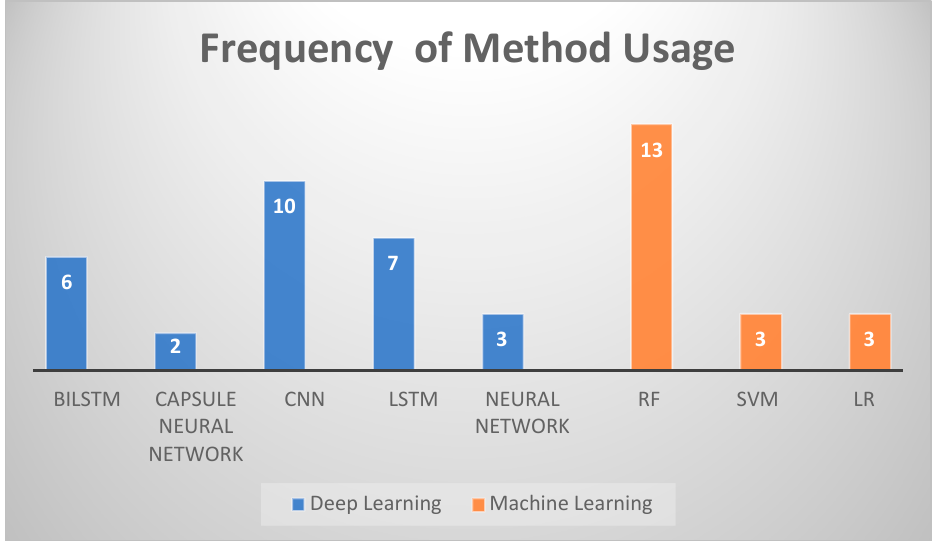
Figure 9. Frequency of method usage.